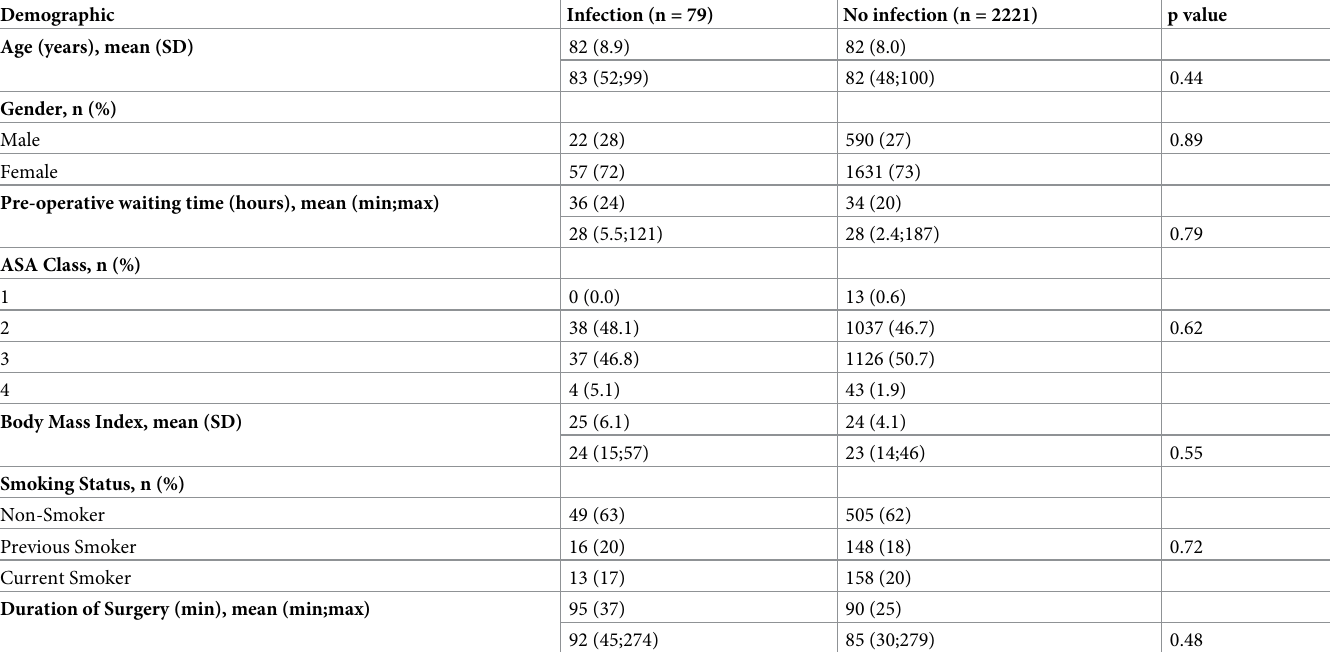
Table 1. Demographic comparison of included patients who developed a PJI within 3 months and those who did